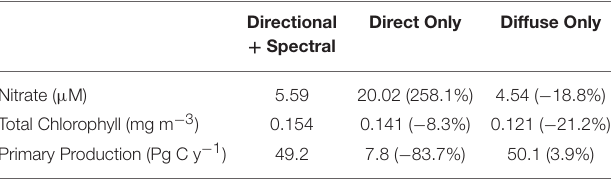
TABLE 3 | Global annual mean nitrate concentrations, global annual median chlorophyll concentrations and global net primary production as a function of directional irradiance.